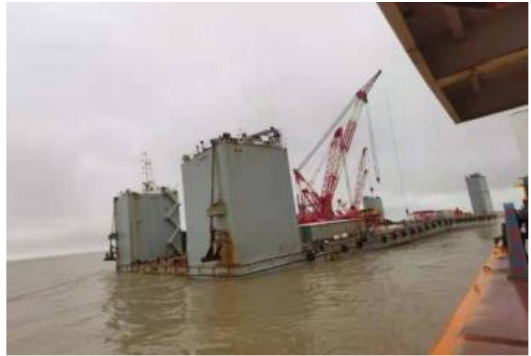
Figure 3. Photo of the accident scene.